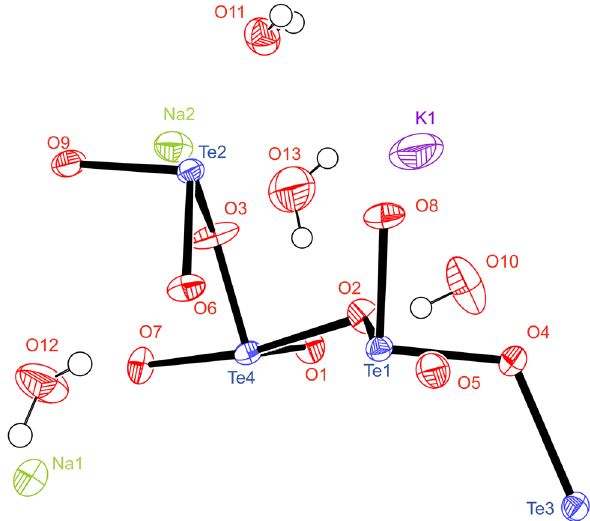
Table 1 contains crystallographic data and Table 2 contains the list of the atoms including atomic coordinates and displacement